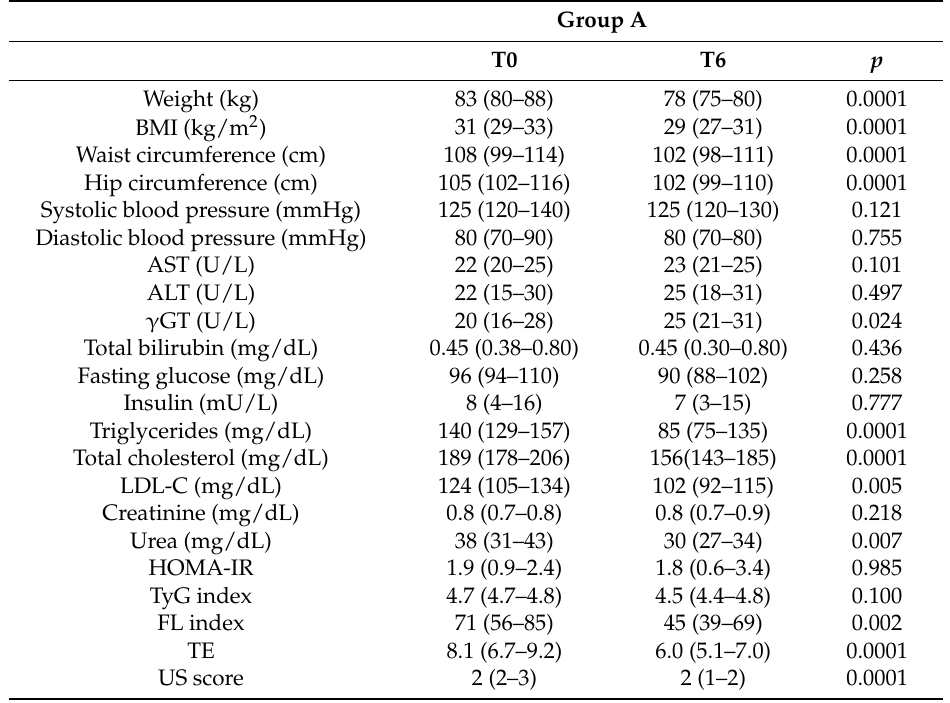
Table 2. Comparison of anthropometric, biochemical and clinical features at baseline (T0) and after six months (T6) of treatment in patients following a low-calorie diet (Group A).